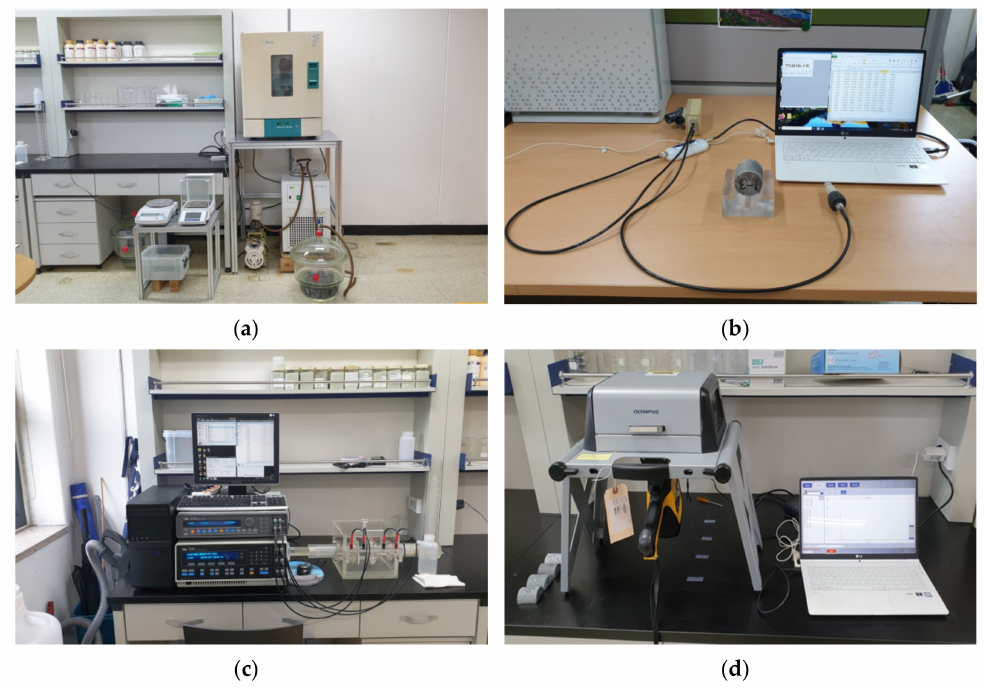
Figure 3. Laboratory measurement system for ( a ) density, ( b ) susceptibility, ( c ) resistivity/ chargeability, and ( d ) X-ray